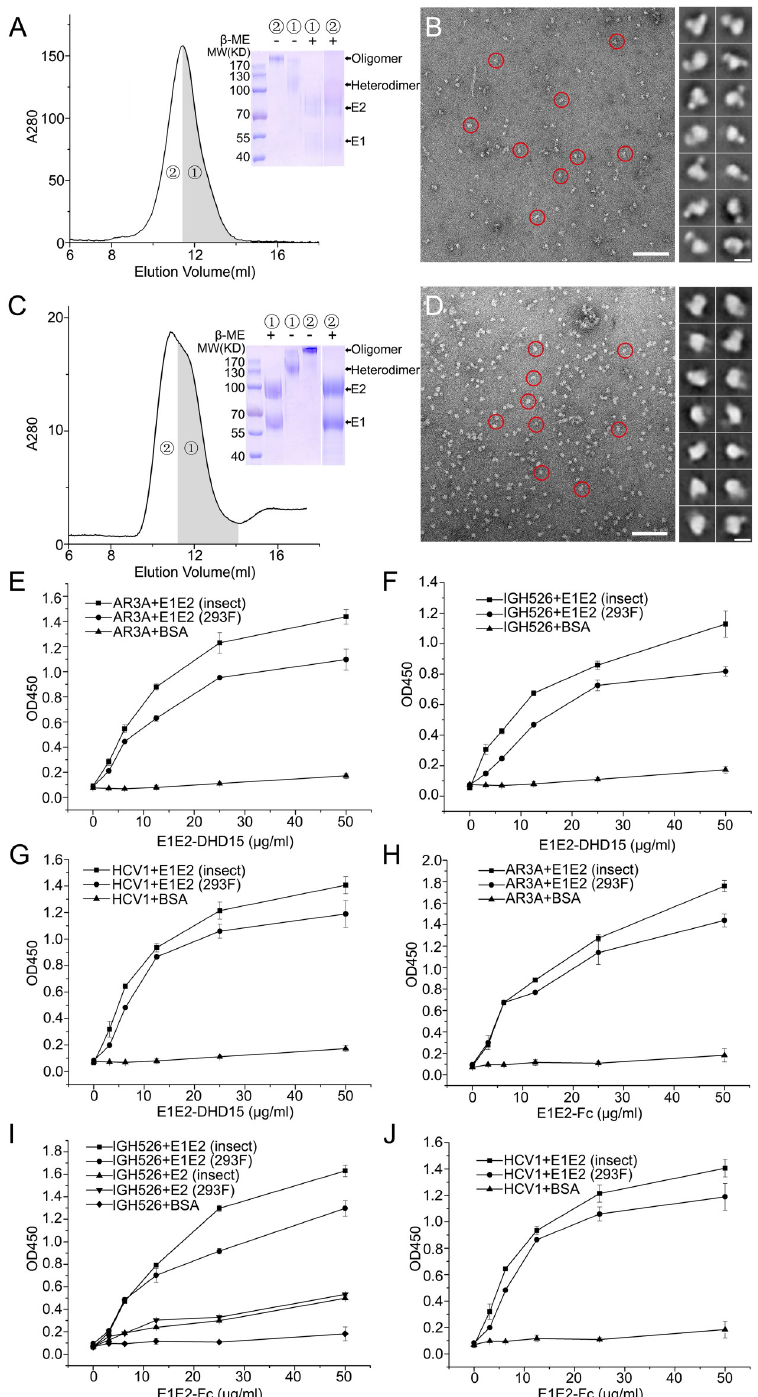
Fig 3. Expression of HCV E1E2 heterodimers in mammalian cells and the interactions of E1E2-DHD15 or E1E2-Fc heterodimer with neutralizing antibodies. (A) The SEC profile and the SDS-PAGE under reducing and non-reducing conditions of the purified E1E2-DHD15 expressed in HEK293 cells. (B) A negative staining EM image of the E1E2-DHD15 particles (left; red circles; bar, 100 nm) and the representative 2D averaging classes (right; bar, 10 nm). (C) The SEC profile and the SDS-PAGE under reducing and non-reducing conditions of the purified E1E2-Fc expressed in HEK293 cells. (D) A negative staining EM image of the E1E2-Fc particles (left; red circles; bar, 100 nm)